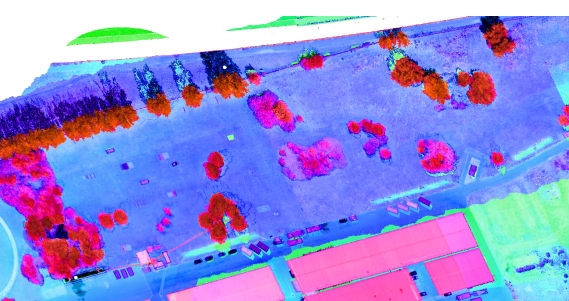
Figure 7: Image from test region